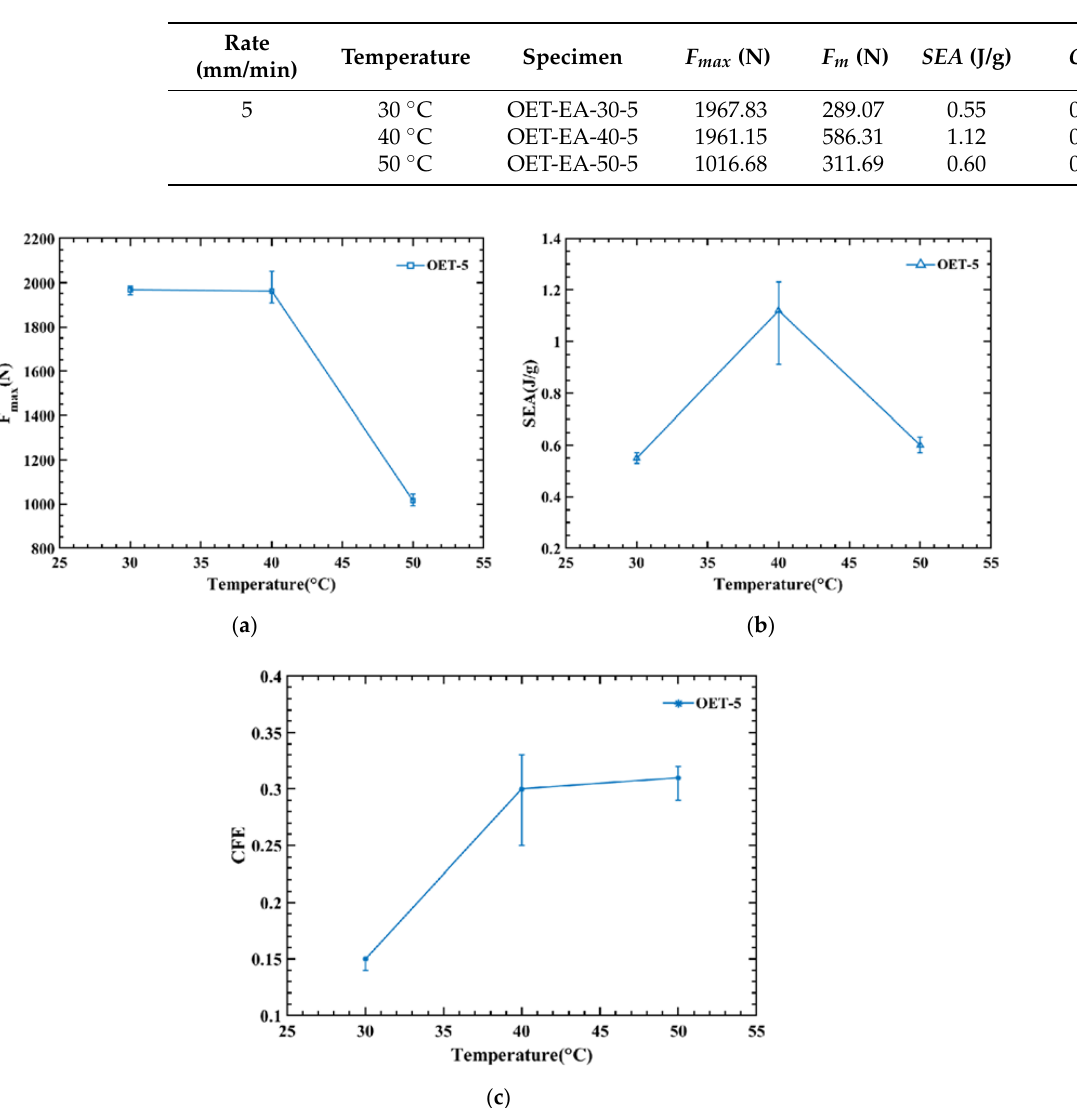
Figure 11. The effect of temperature on three Energy absorption indicators: ( a ) F max , ( b ) SEA, and ( c ) CFE. ( c ) CFE